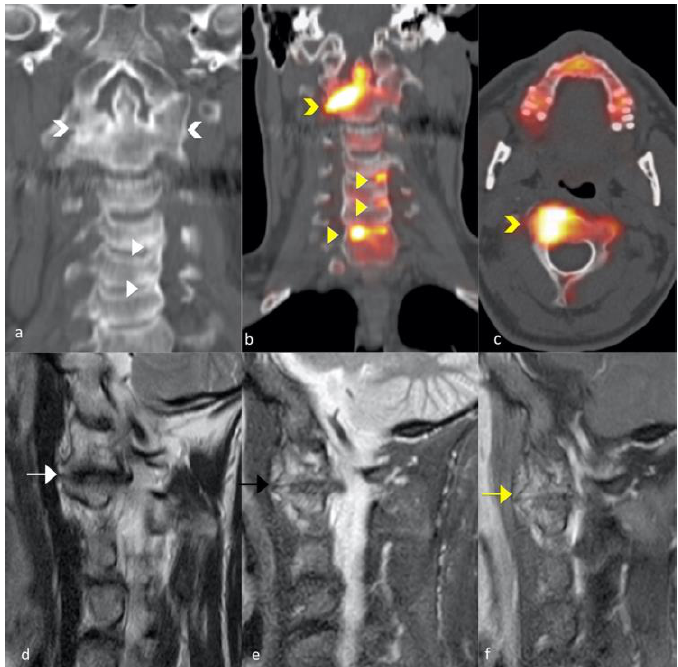
Figure 2. A 56-year-old man with axial PsA. CT coronal image of the cervical spine ( a ) shows the fusion of both atlanto-axial articulations; huge horizontal oriented osteophytes with extensive sclerosis of the articular cortical bone was observed at the right atlanto-axial articulation. Sodium 18F-Fluoride PET-CT of the cervical spine on the coronal ( b ), axial ( c ), and saggital plane ( d ) shows the increase in tracer uptake at the dens in extension to right lateral mass (yellow chevron); focal areas with increase in tracer uptake were observed at the antero-lateral corners on the left side of C3-C4 and C4-C5 levels and on the right antero-lateral corner of the vertebral plate of C7 (yellow-arrow-heads); the corresponding CT image ( a ; arrowheads) shows signs of structural damages with bone sclerosis also with small cortical erosions. Sagittal T2-weighted and short tau inversion recovery (STIR) T2-weighted TSE images ( d , e ) show signs of structural damages at the right atlanto-axial articulation with bone formation and bone oedema with the involvement of periarticular soft tissues (arrows); sagittal fat-suppressed gadolinium-enhanced T1-weighted FS TSE ( f ), show contrast enhancement of articular space, also involving cortical bone and periarticular soft tissue, in keeping with active synovitis (yellow arrow).